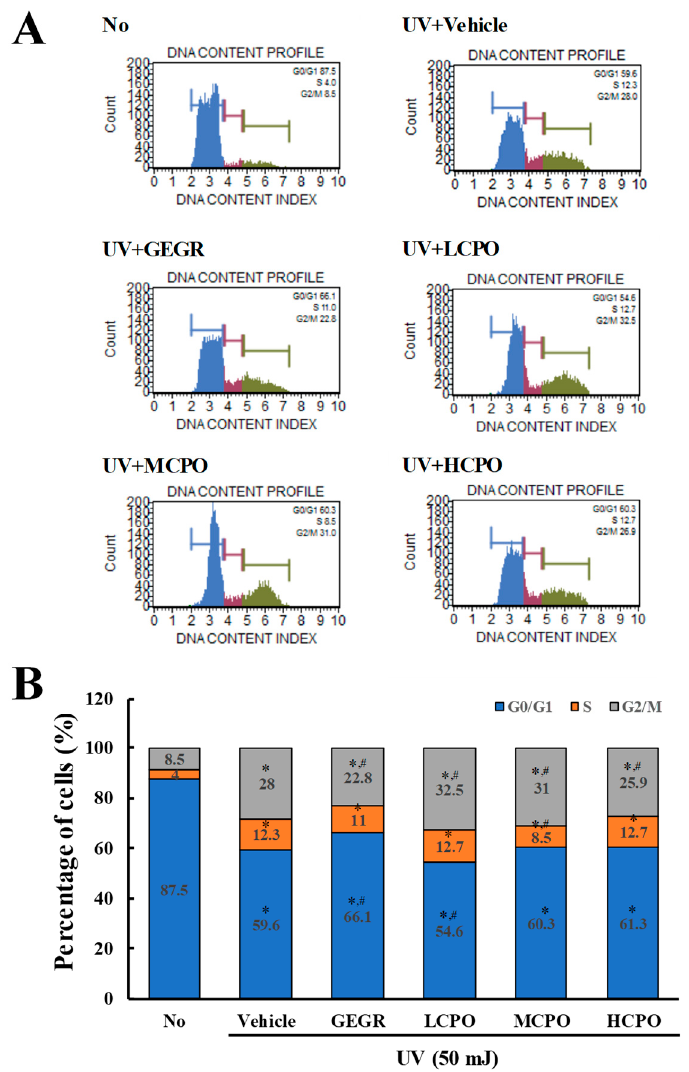
Figure 5. Cell cycle analysis after UV + CPO treatment. ( A ) Cell cycle histograms obtained using flow cytometry. Cell cycle distributions were determined by flow cytometric analysis of propidium iodide (PI) stained NHDF nuclei. ( B ) Percentage of cell numbers in each cell cycle. Numbers of cells in the G0 / G1, S, and G2 / M stages were determined after UV + CPO treatments. Two to three wells per group were PI stained and cell numbers in each phase were measured in duplicate. Data are reported as the means ± SD. * p < 0.05 compared to the No group. # p < 0.05 compared to the UV + Vehicle group. Abbreviations: LCPO, low concentration CPO; MCPO, medium concentration CPO; HCPO, high concentration CPO; GEGR, gallotannin-enriched extract of Galla